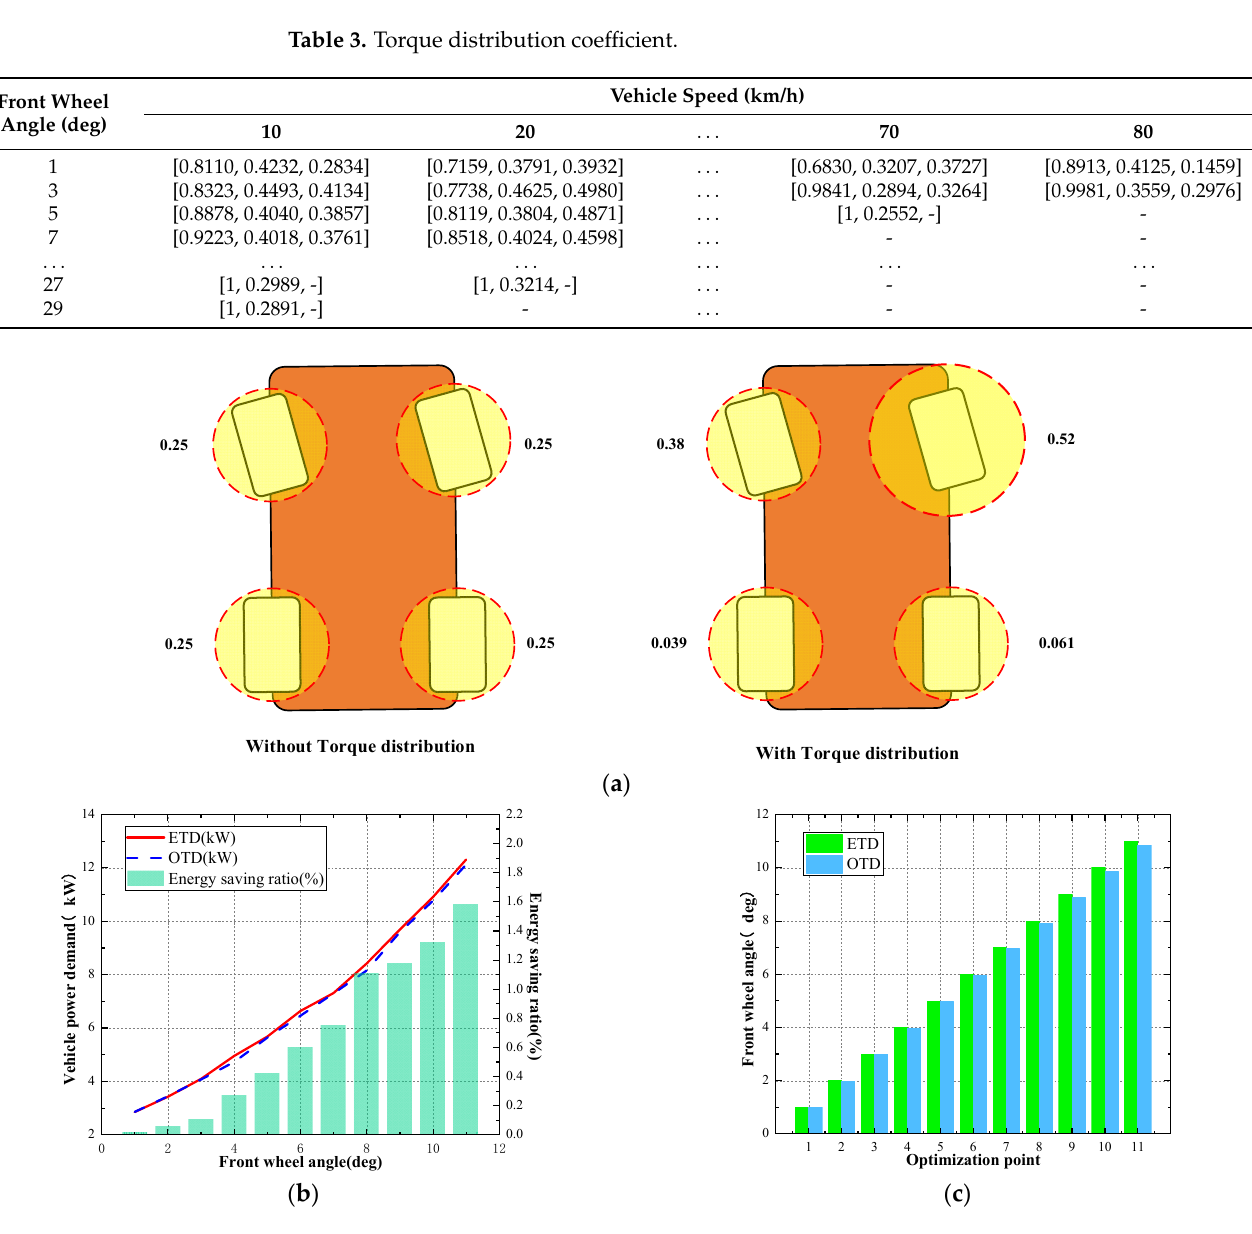
Figure 7. Energy ‐ saving effect of optimal torque distribution. 6. Conclusions 1. Through the theoretical derivation of a 7 ‐ DOF vehicle dynamics model and the analysis of the energy consumption of the whole vehicle, the impact of the TVD control on the reduction in vehicle cornering energy consumption was explained.